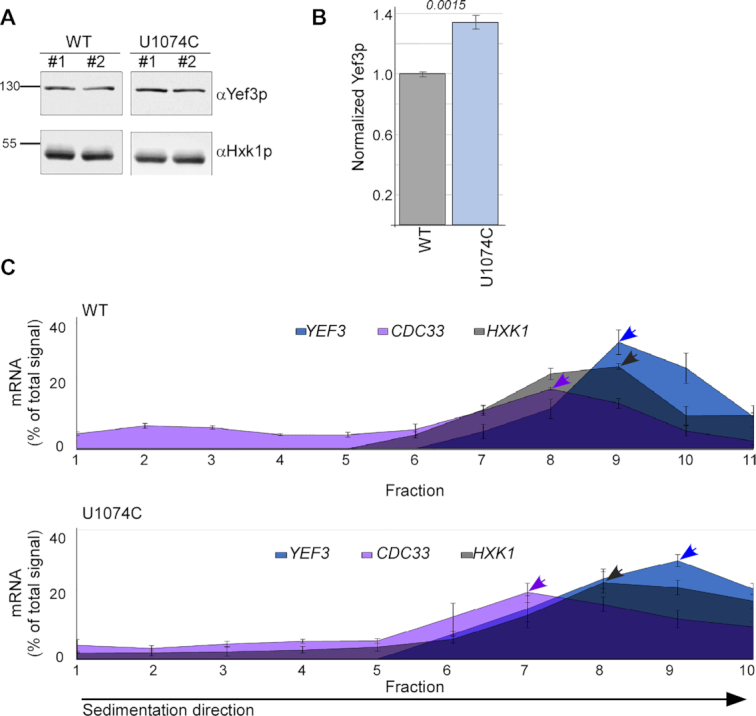
Ψ1074 imposes a translation regulatory role. (A) Cells expressing either WT or U1074C transcripts were subjected to western analysis with antibodies recognizing Yef3p or Hxk1p. Two independent protein extractions are presented. Signals are from the same blot from which irrelevant lanes were cropped. (B) Quantification of the western blots for Yef3p (normalized to the Hxk1p) from three independent biological repeats. Error bars are SEM, and P-value was calculated by the dependent samples one-tailed t-test. (C) Polysomal separations on sucrose gradients for WT and U1074C cells were analyzed by northern analysis for the indicated transcripts. Graphs present the northern signals quantifications from three independent biological repeats (actual blots are in Supplementary Figure S3). Arrowheads point to the fraction with the highest signal (‘peak fraction’) per mRNA. Error bars are SEM of three independent biological repeats. Note that the fraction collector was inadvertently set to collect 10 fractions for U1074 gradients while the WT were separated into 11 fractions. Yet in both cases the entire gradient was collected (gradients’ OD254 profiles are provided in Supplementary Figure S3A).